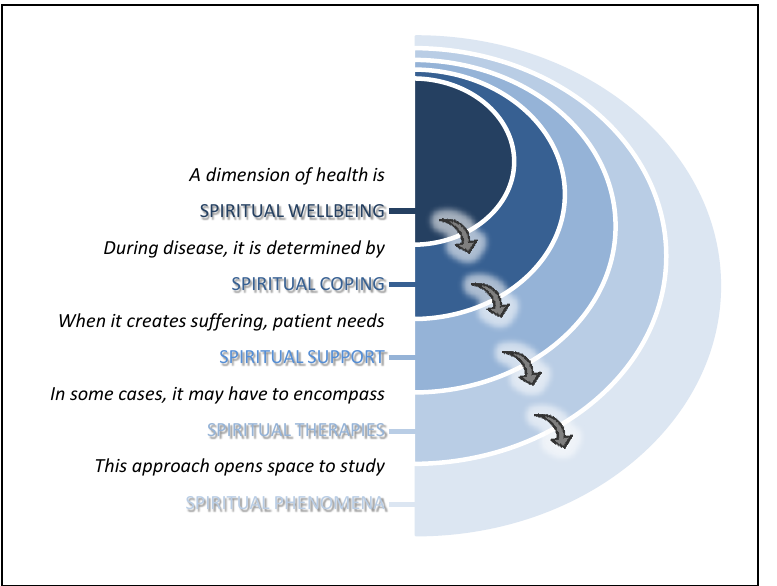
Figure 1. Expressions of the spiritual dimension explored in this paper, which are progressive in